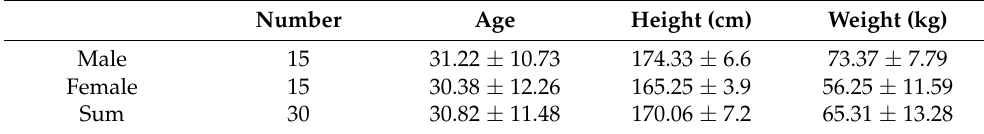
Table 1. Basic information about the